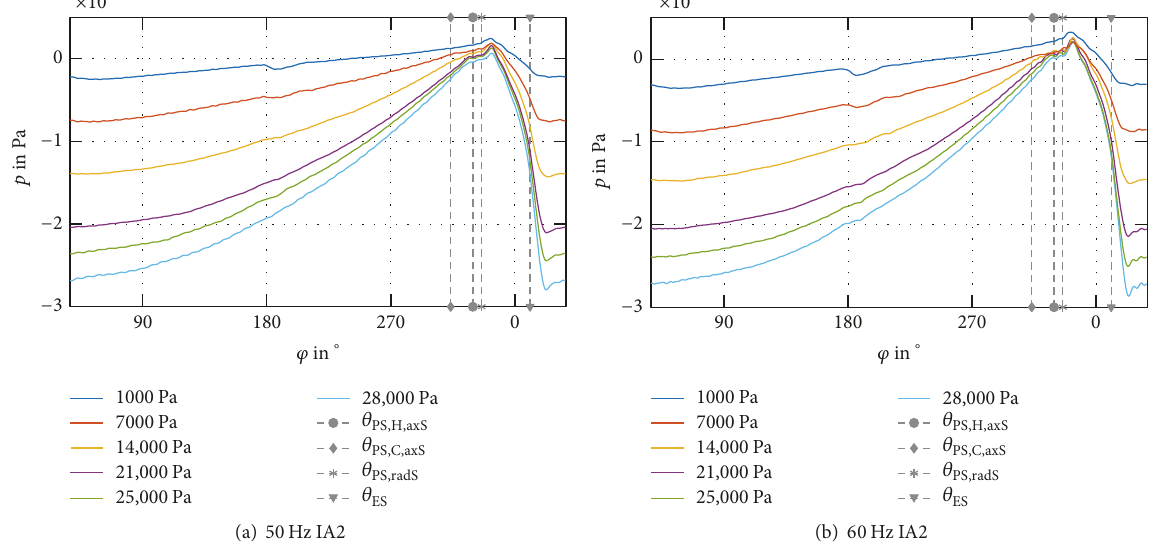
Figure 12: Sensor-averaged and phase-locked ensemble-averaged pressure on the blade surface for different operating points Δ𝑝 12, red and rotational